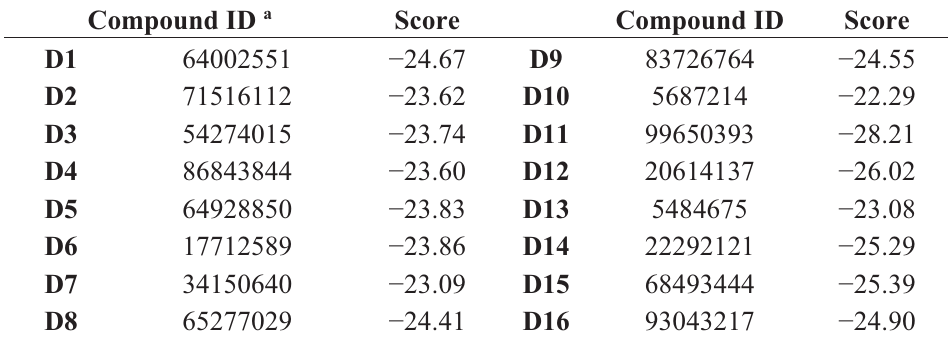
Table 2. VLS docking score results of compounds selected for cell-based